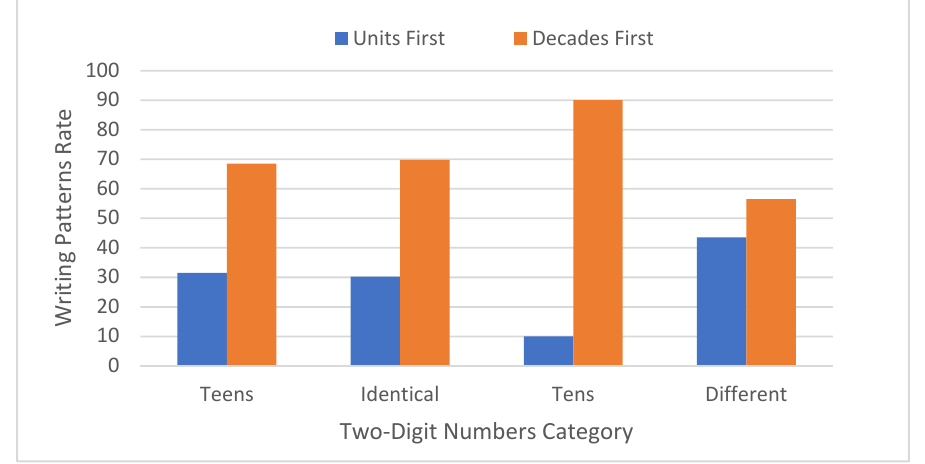
Figure 1. The units first (right to left) and decades first (left to right) writing pattern rates as a function of two-digit numbers category (teens, identical, tens and different).